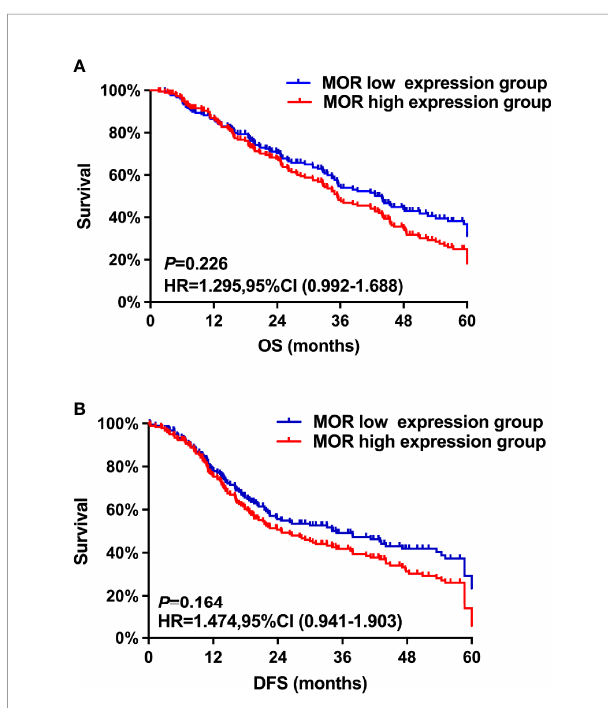
FIGURE 1 | The study ’ s co-primary outcomes were (A) overall survival analysis based on MOR expression and (B) disease-free survival based on MOR